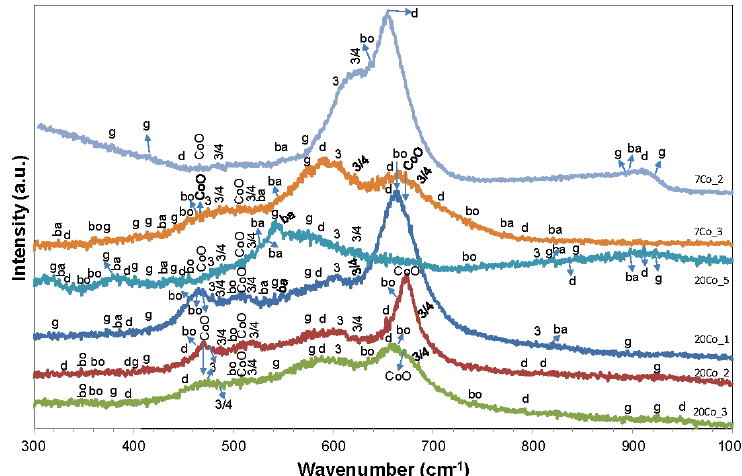
Figure 11. Representative Raman spectra from the surface of Al-7 wt.% Co and Al-20 wt.% Co, after cyclic polarization (3.5 wt.% NaCl, 25 °C). d: diaspore, b: boehmite, g: gibbsite, ba: bayerite, 3/4: Co 3 O 4 , 3: CoOOH.